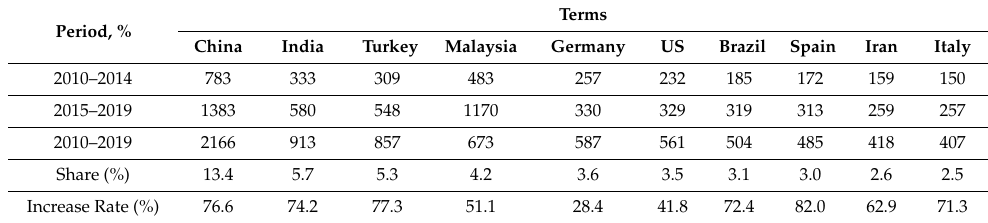
Table 2. Term frequency (TF) by